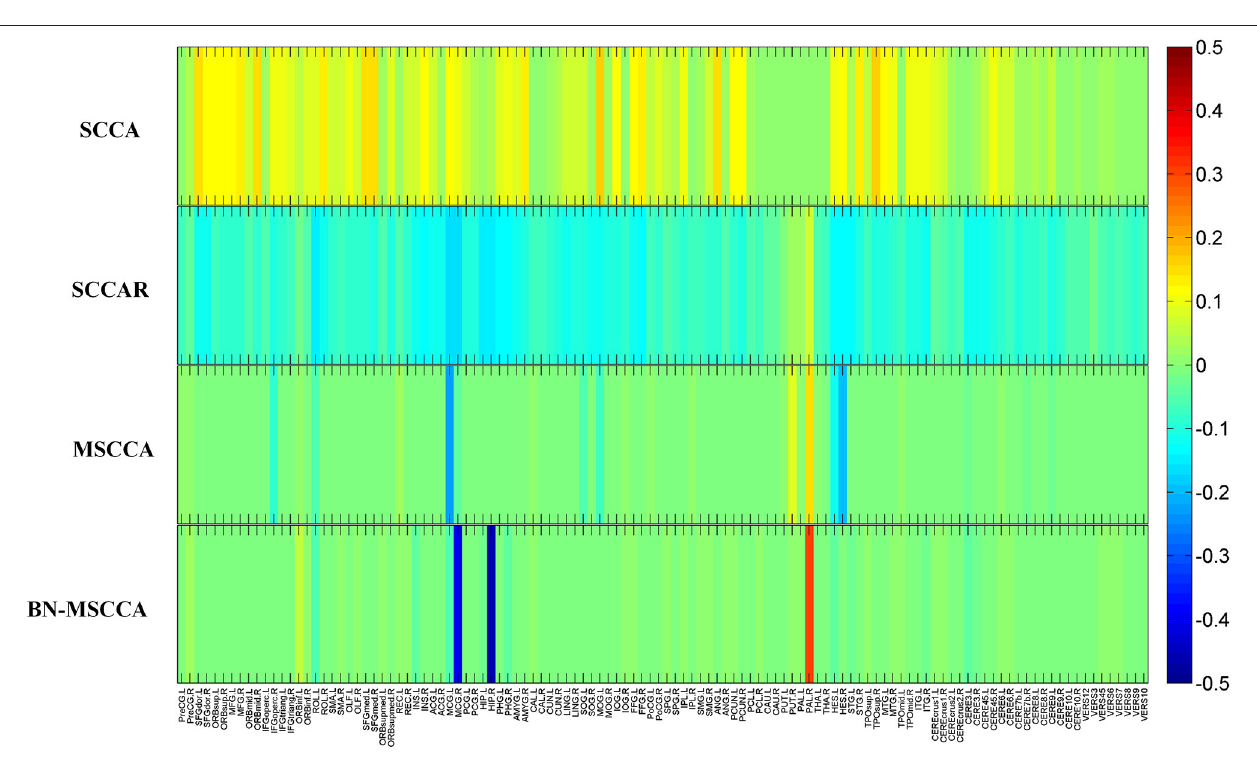
Frontiers in Neuroscience |